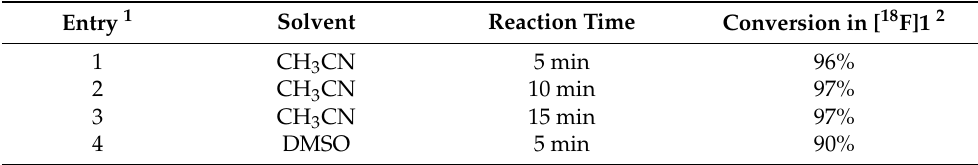
Table 1. Reaction conditions for the radiofluorination of 2 ‐ fluoro ‐ 4 ‐ nitrobenzonitrile.